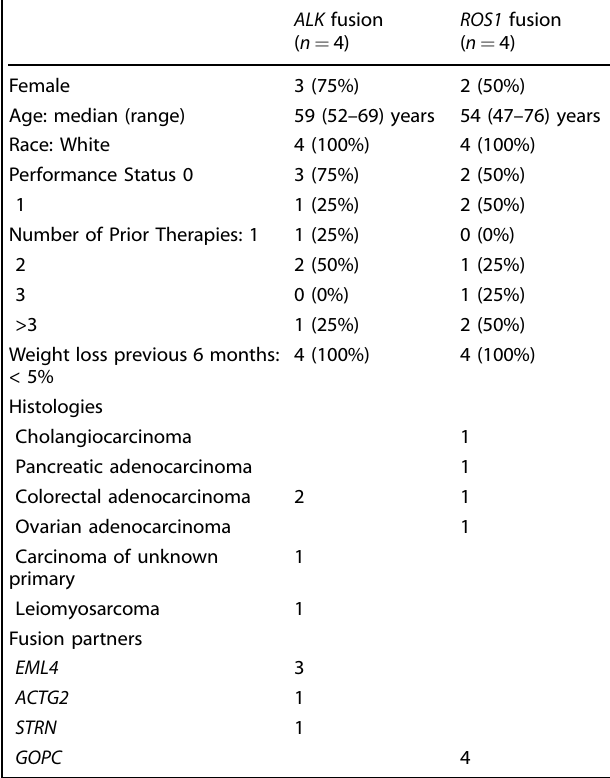
Table 1. Patient